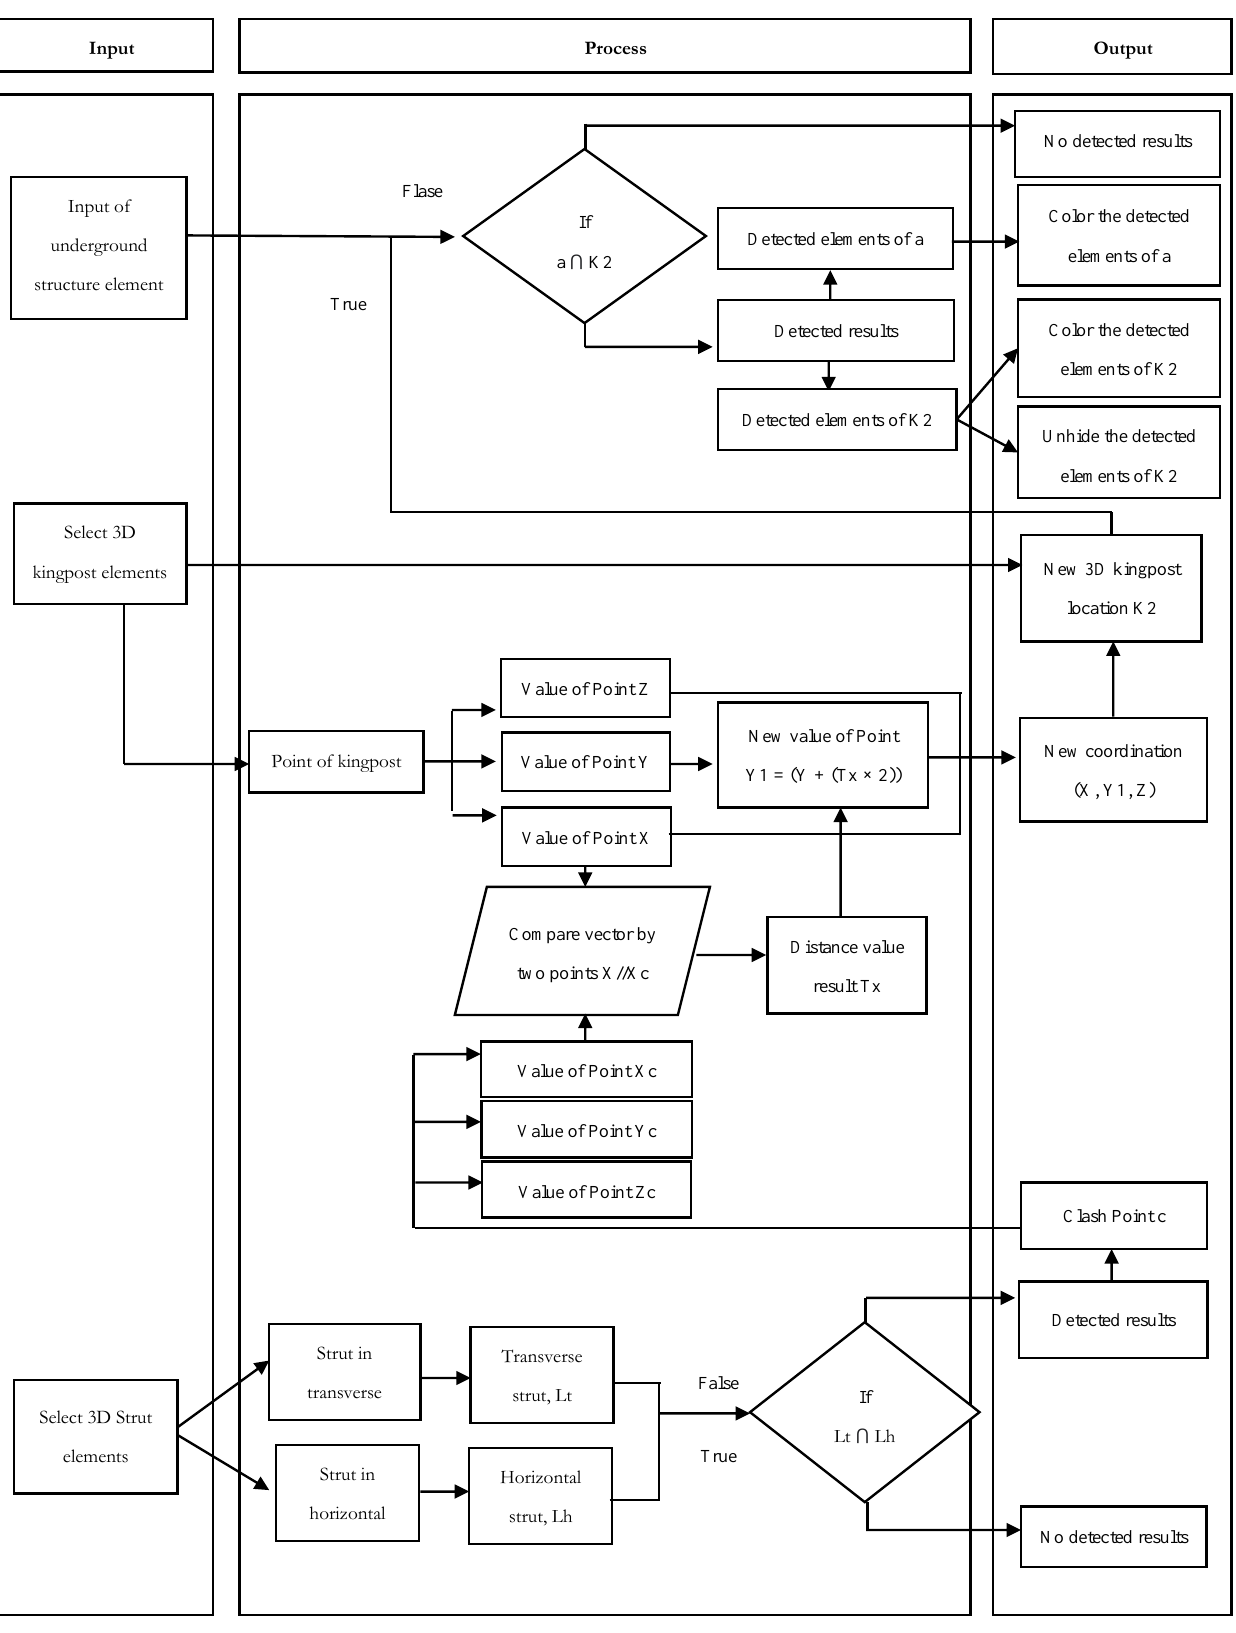
Figure 14. A module of kingpost relocation to the second location.